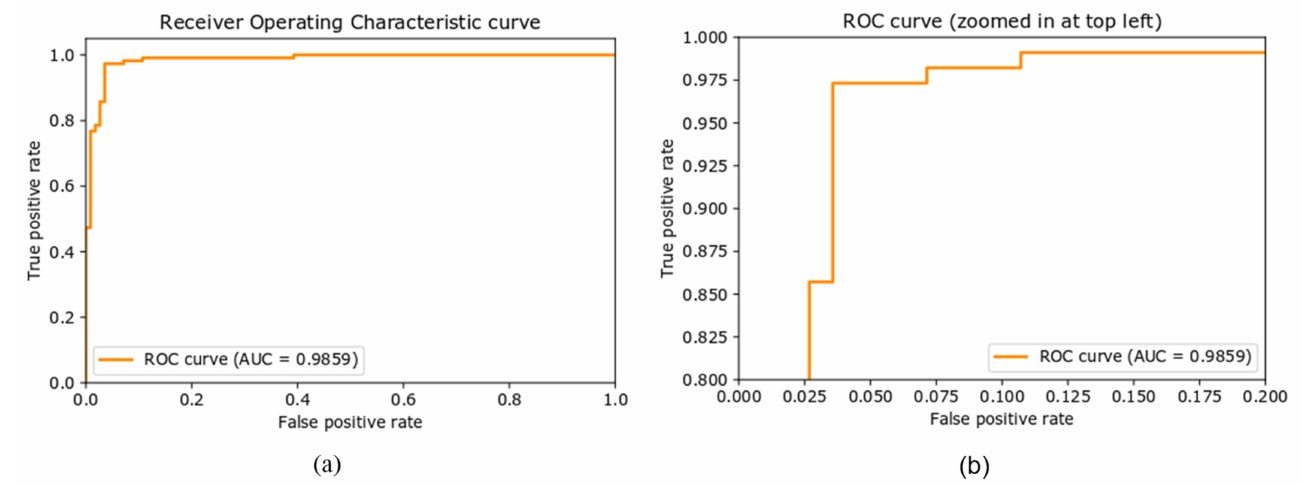
Figure 7. ( a ) Receiver operative characteristic curve (ROC), ( b ) ROC curve with zoomed representation. Precision–Recall